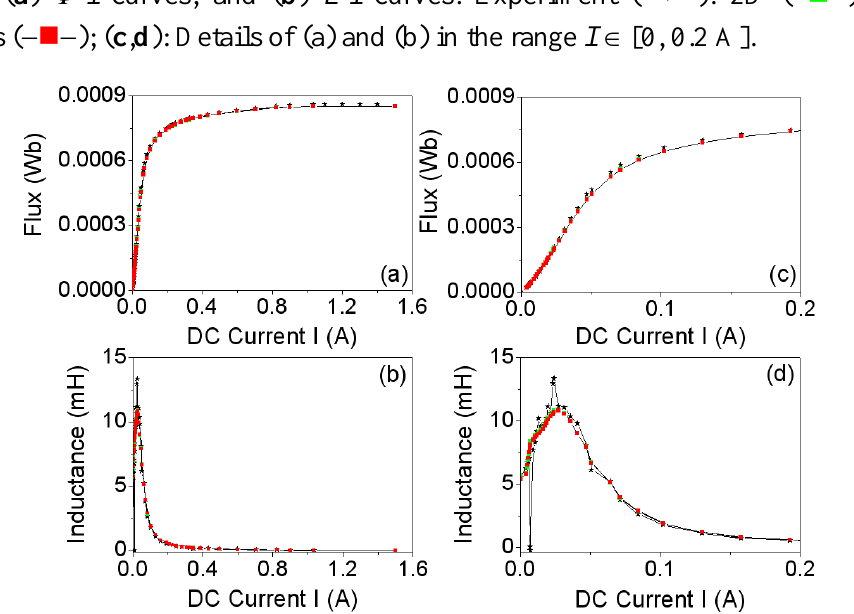
Figure 8. ( a ) Φ - I curves; and ( b ) L - I curves. Experiment (    ). 2D (    ) and